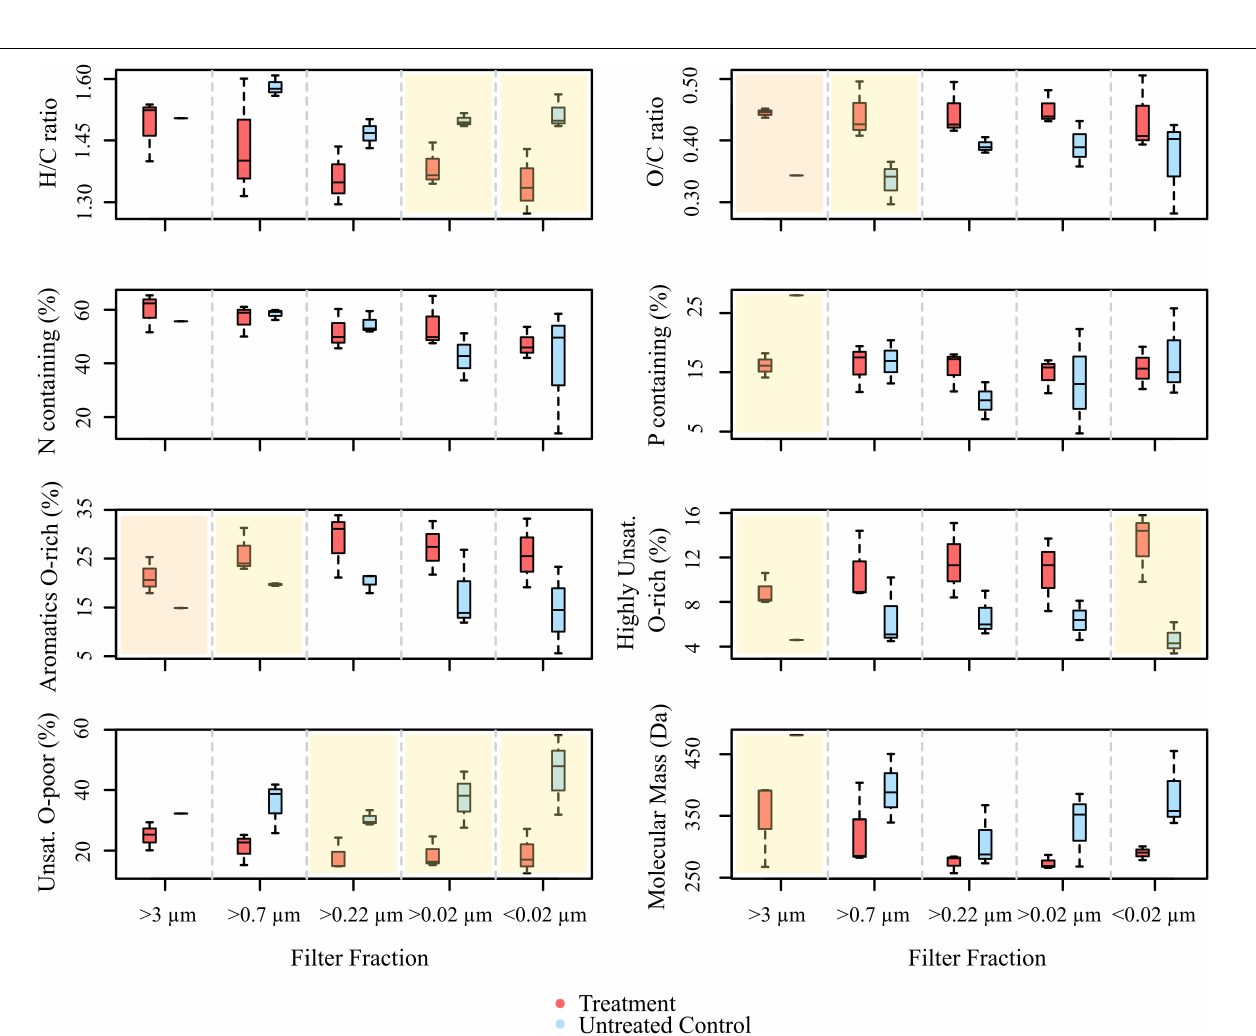
FIGURE 4 | Boxplots showing the molecular compositions of signal intensity-weighted averages of various compound groups, comprised from all masses with assigned molecular formulae detected in the treatments and controls of the culture experiment (ANOVA with Tukey HSD test, n = 1 for > 3 µ m fraction of the control, n = 3 for the rest. The overlay in yellow indicates significant differences between treatment and control ( p < 0.05), panels overlain in orange represent highly significant differences ( p < 0.005).